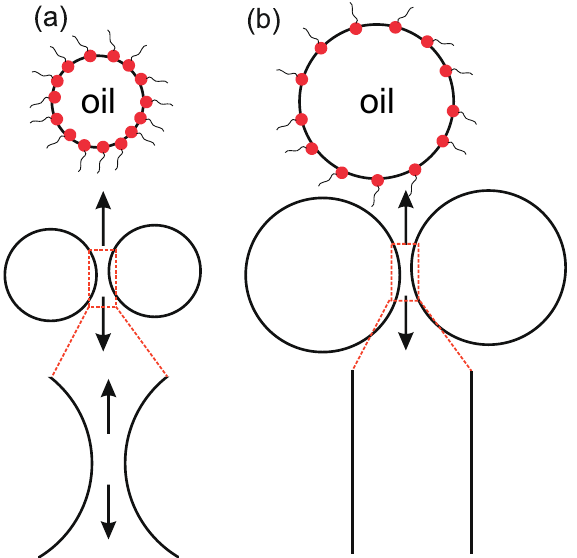
Figure 8. Droplet size seems to have no influence on the coalescence trends (even at elevated temperatures). The plausible explanation is the counteracting effects of droplet coverage (by the surfactant molecules) and the ease of drainage from a flatter film ( a ), compared to that from a more curved film ( b